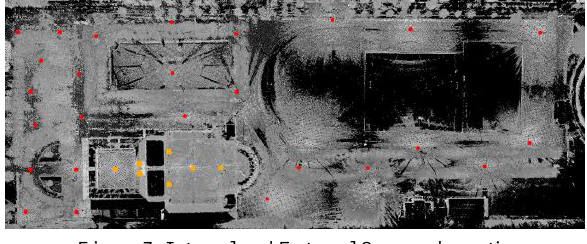
Figure 7. Internal and External Scans schematic.